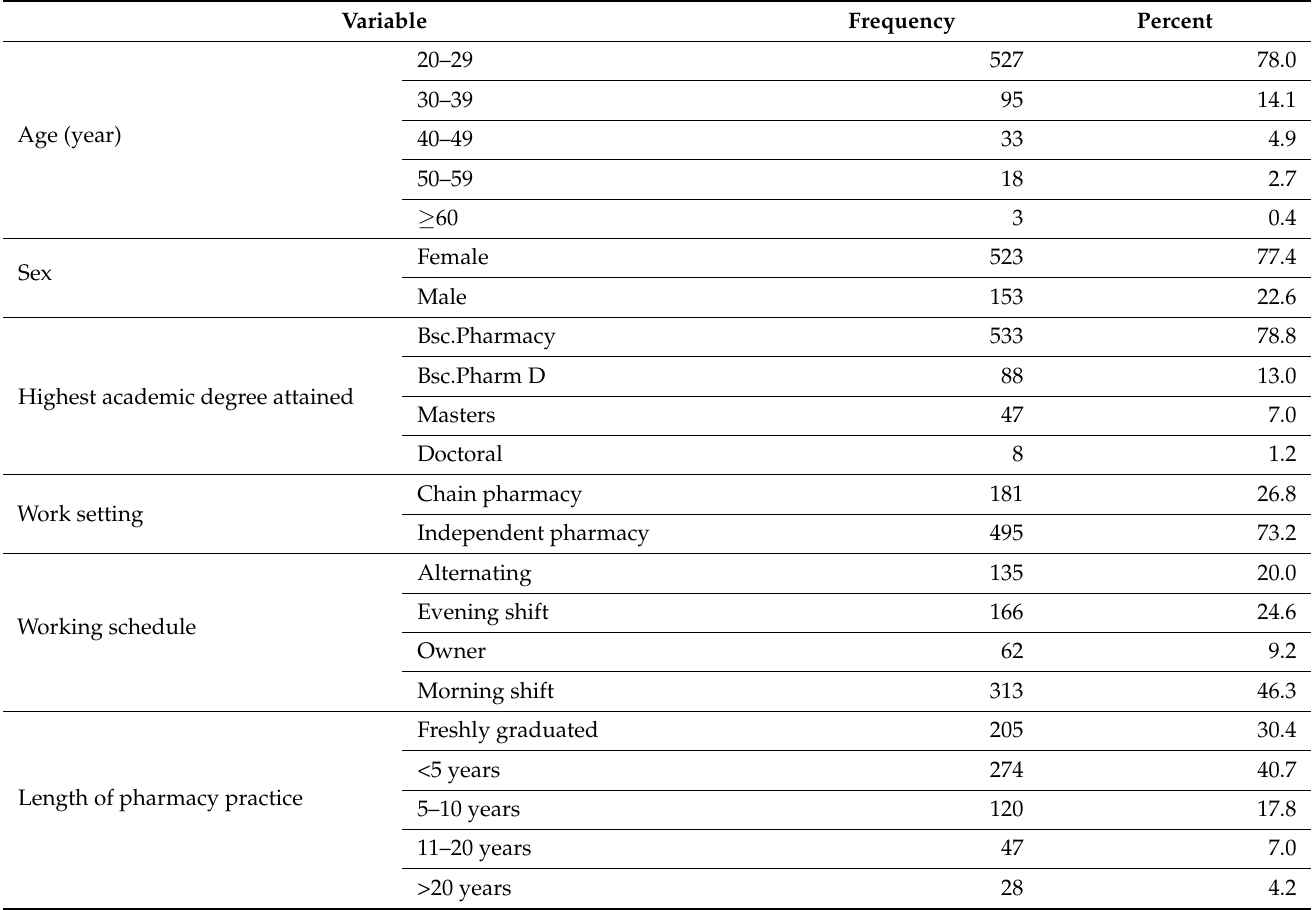
Table 1. Demographic and practice characteristics of respondent